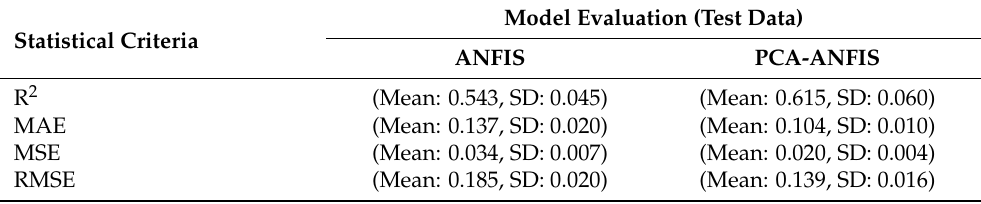
Table 6. Comparison of predicted COVID-19 prevalence using the ANFIS and PCA-ANFIS